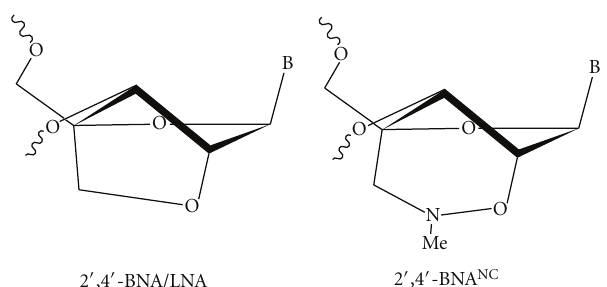
Figure 1: Structures of the BNAs. The chemical structure on the left is the original BNA, 2 (cid:2) ,4 (cid:2) -BNA/LNA, and the structure on the right is 2 (cid:2) ,4 (cid:2) -BNA NC